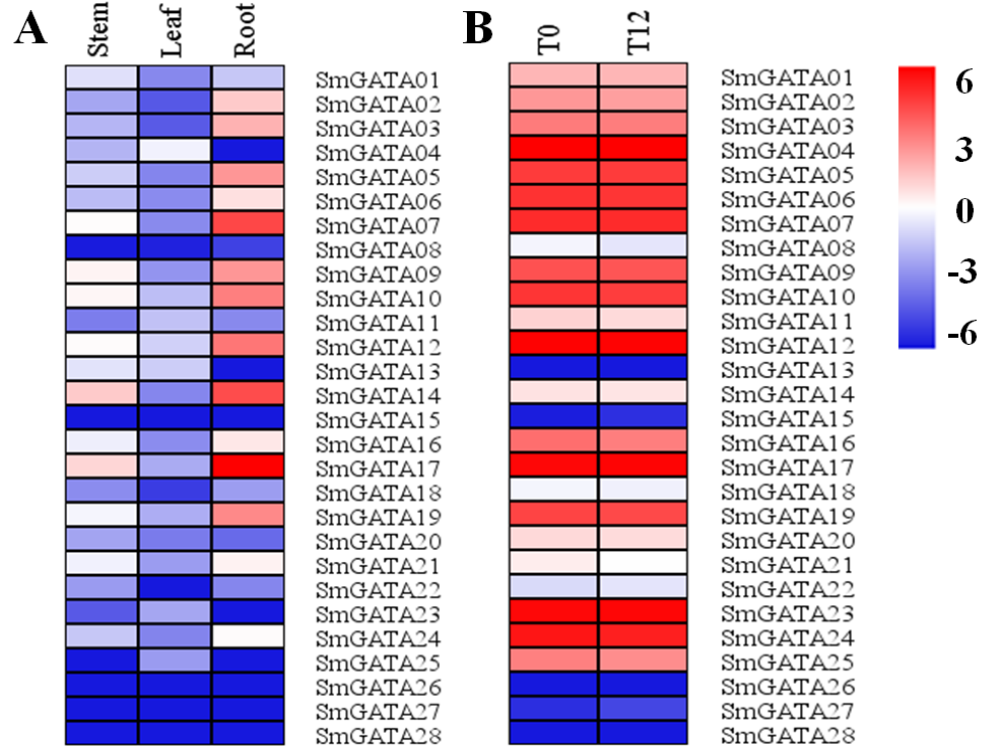
Figure 6. Expression analysis of SmGATA s based on transcriptome datasets. The FPKM values were transformed to log 2 |value+0.0005|. ( A ) Expression patterns of 28 SmGATA s in stem, leaf and root. ( B ) Expression analysis of SmGATA s in leaf under MeJA treatment. The control group was expressed as T0; MeJA-treated S. miltiorrhiza leaves for 12 h were expressed as T12. Changes of genes expression are represented by the color scale.